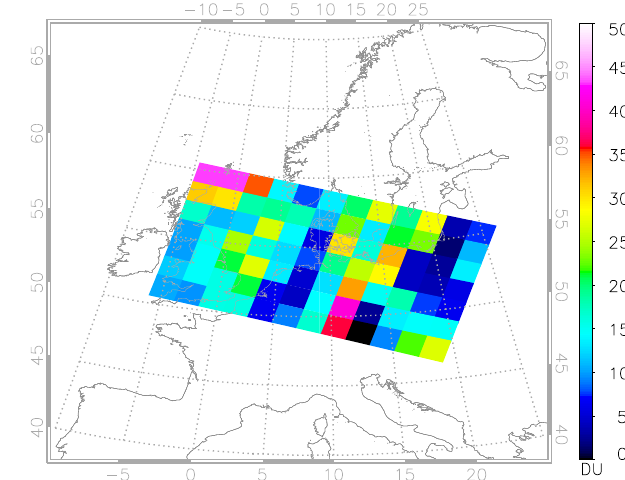
Fig. 7c. The partial ozone columns (DU) in the second layer of a retrieval (6 to 12km) over Europe for the green pixels that were illustrated in Fig. 6.